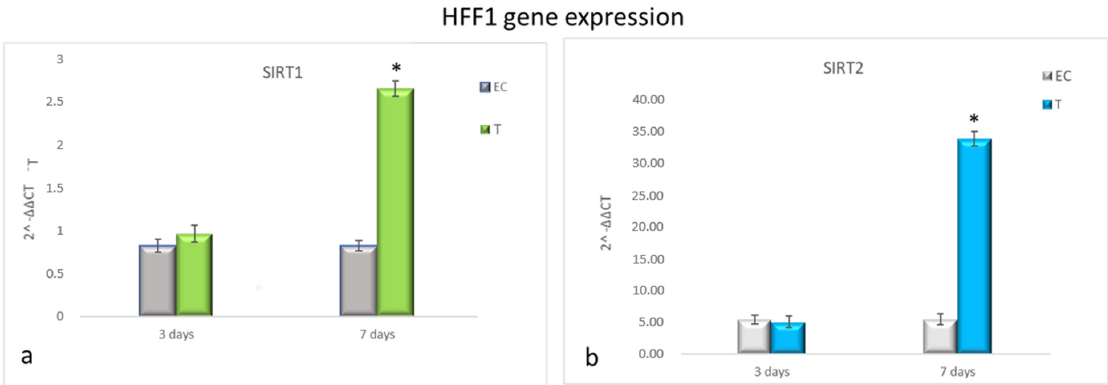
Figure 4. Gene expression analysis of SIRT1 and SIRT2 in HFF1 ( a , b ). HFF1 was exposed to the different culturing condi- tions. mRNA levels of SIRT1 ( a ) and SIRT2 ( b ) in EC (grey bars) and T (colored bars) are expressed as fold change (2 −∆∆ ct ) compared with negative controls (UnC = 1). EC and T cells were exposed to UV light for 2 min at 10 cm distance from the lamp to induce oxidative stress. UnC samples were not exposed to UV light and not pre-treated with NanoPCL-M (UnC = 1), T samples were pre-treated with NanoPCL-M before UV stress exposure. * p ≤ 0.05.